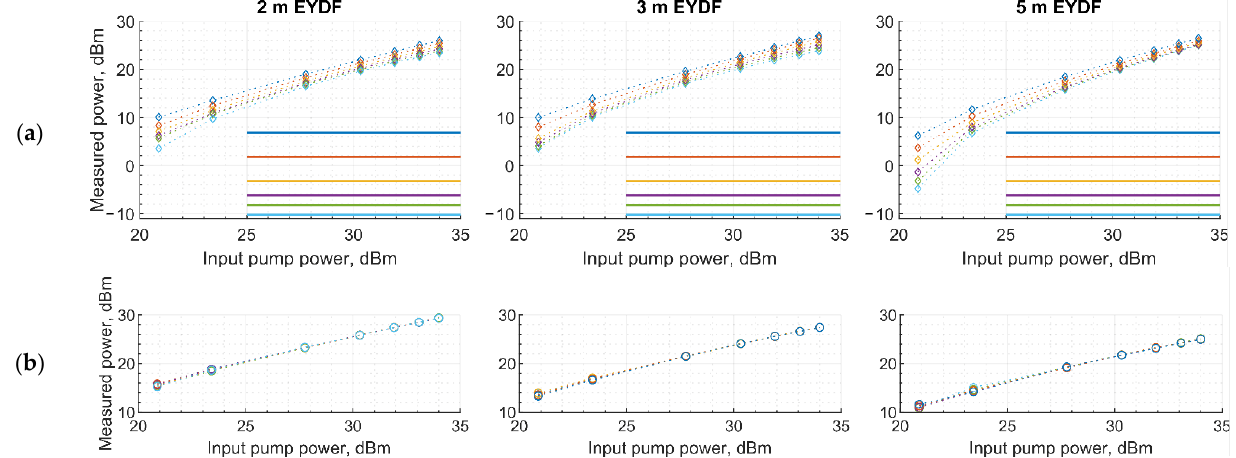
Figure 12. Measured power for ( a ) output signal and ( b ) residual pump coming out of the EYDF. Horizontal lines indicate total input signal power and correspond to −10 ( top ), −15, −20, −23, −25, −27 ( bottom ) dBm per channel.